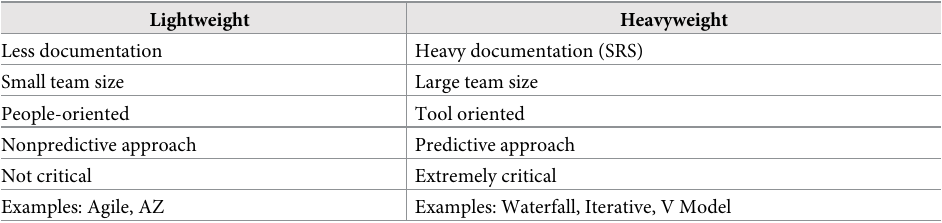
Table 1. Comparison of heavyweight and lightweight methodologies